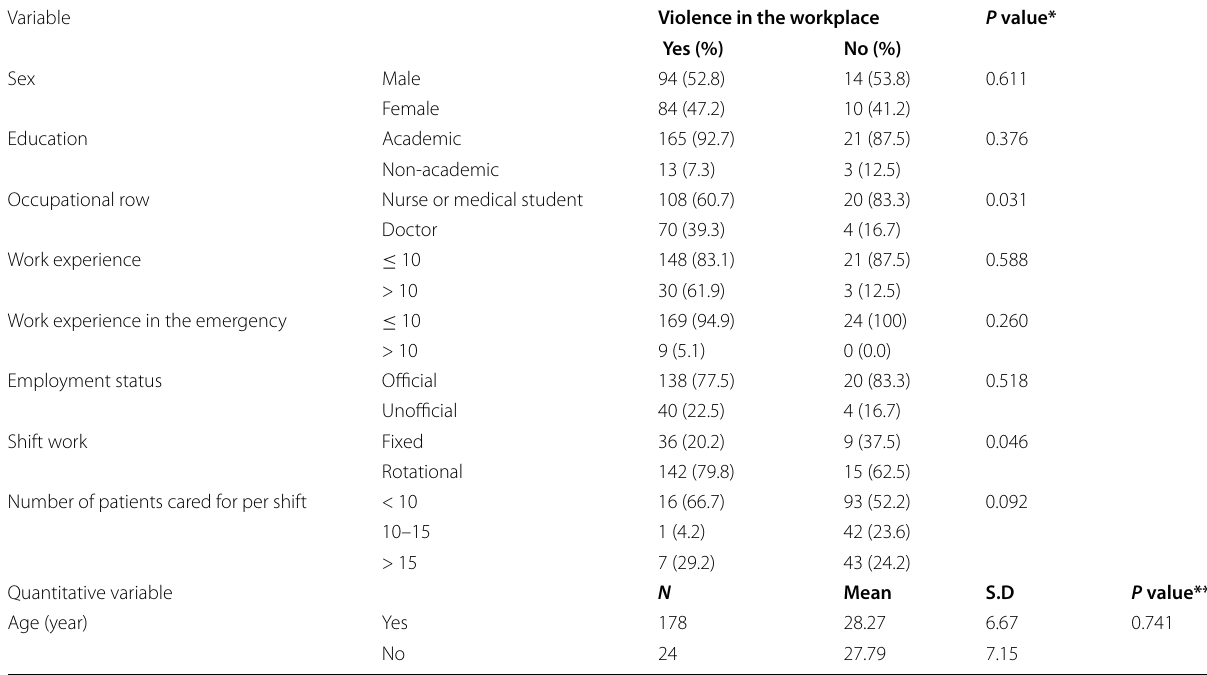
Table 5 The relationship between demographic variables and violence in the workplace in population under